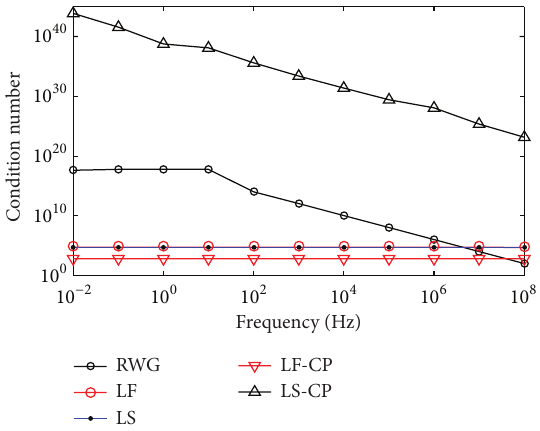
Figure 6: Condition numbers versus